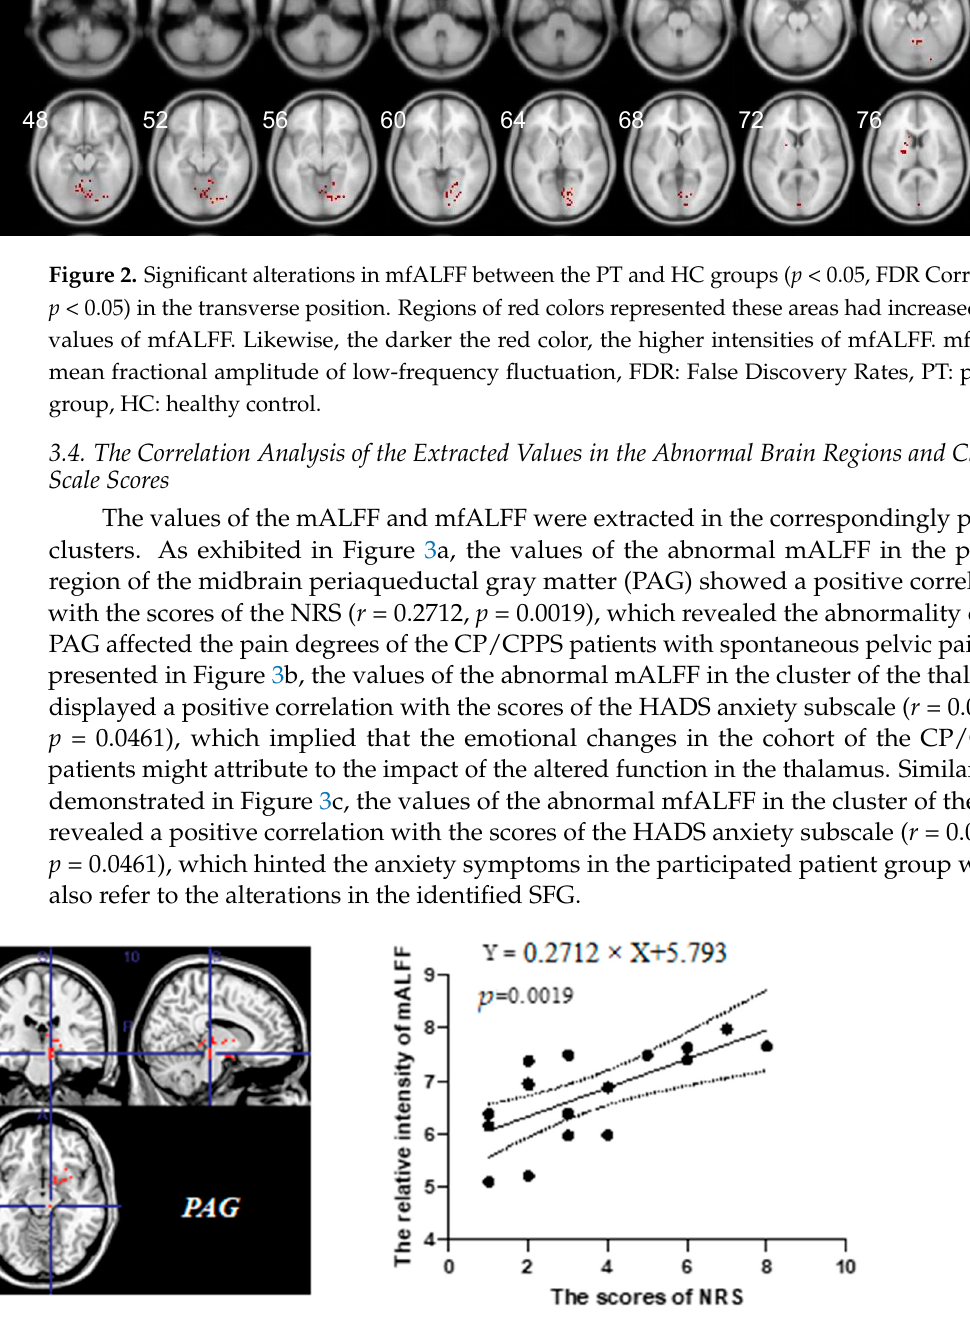
Figure 3. The Outcomes of Correlation Analysis among ROIs and Clinical Scale Scores. ( a ) The cor- relation between the scores of NRS and mALFF values in PAG ( r = 0.2712, P = 0.0019, R 2 = 0.4620). ( b ) The correlation between the scores of HADS anxiety subscale and mALFF values in thalamus ( r = 0.08477, p = 0.0461, R 2 = 0.2261). ( c ) The correlation between the scores of HADS anxiety subscale and mfALFF values in superior frontal gyrus ( r = 0.07102, p = 0.0282, R 2 = 0.2667). There was no correlation between the relative values of mALFF and mALFF in the other ROIs and the scores of clinical scales. ROIs: regions of interest, NRS: Numeric Rating Scale, mALFF: mean amplitude of low-frequency fluctuation, PAG: periaqueductal gray matter, HADS: Hospital Anxiety and Depres- sion Scale, mfALFF: mean fractional amplitude of low-frequency fluctuation.